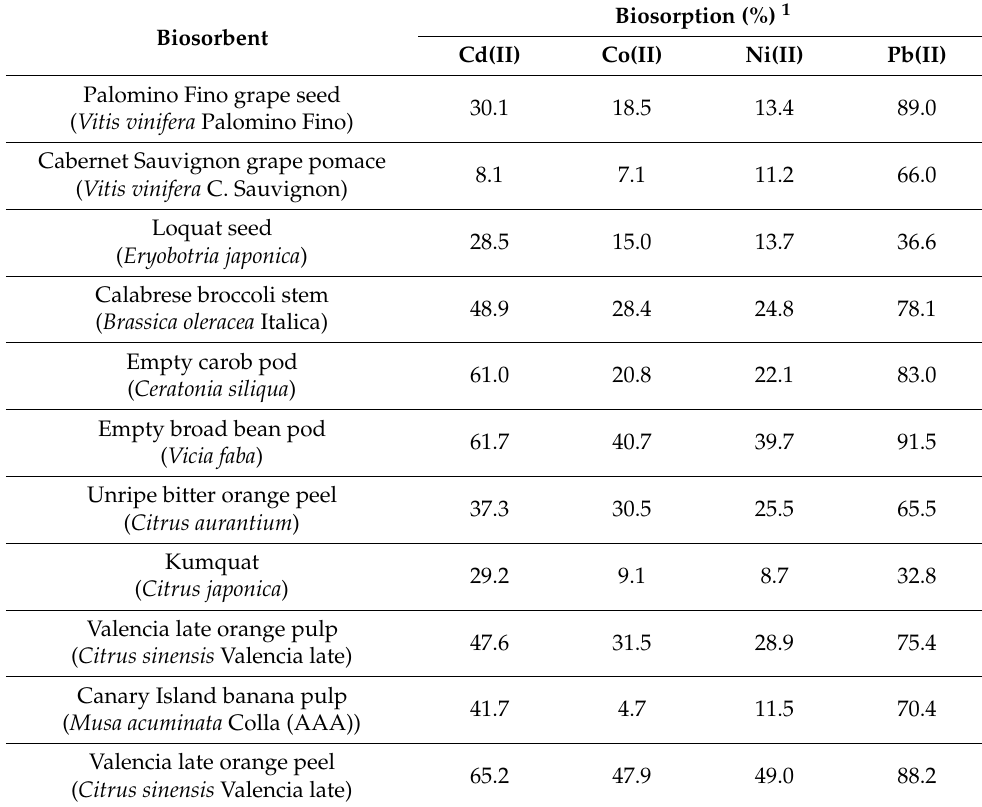
Table 2. Biosorption percentage of Cd(II), Co(II), Ni(II) and Pb(II) in aqueous solution for the different biosorbents